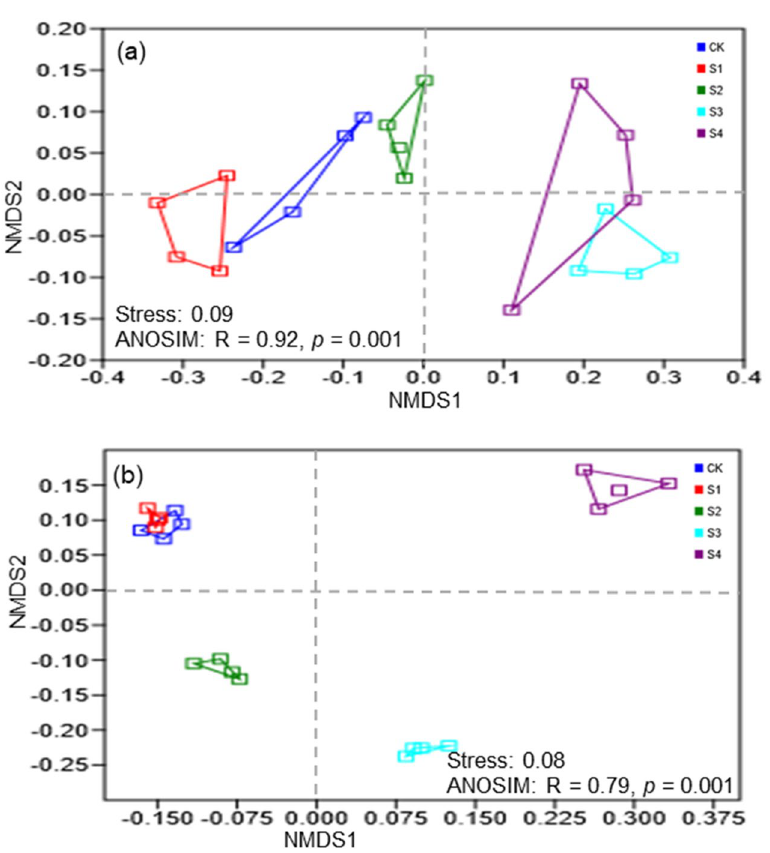
Figure 1. The NMDS ordinations based on the relative abundance of the bacterial communities ( a ) and Shannon diversity ( b ) of the soil bacterial phyla under five salinity